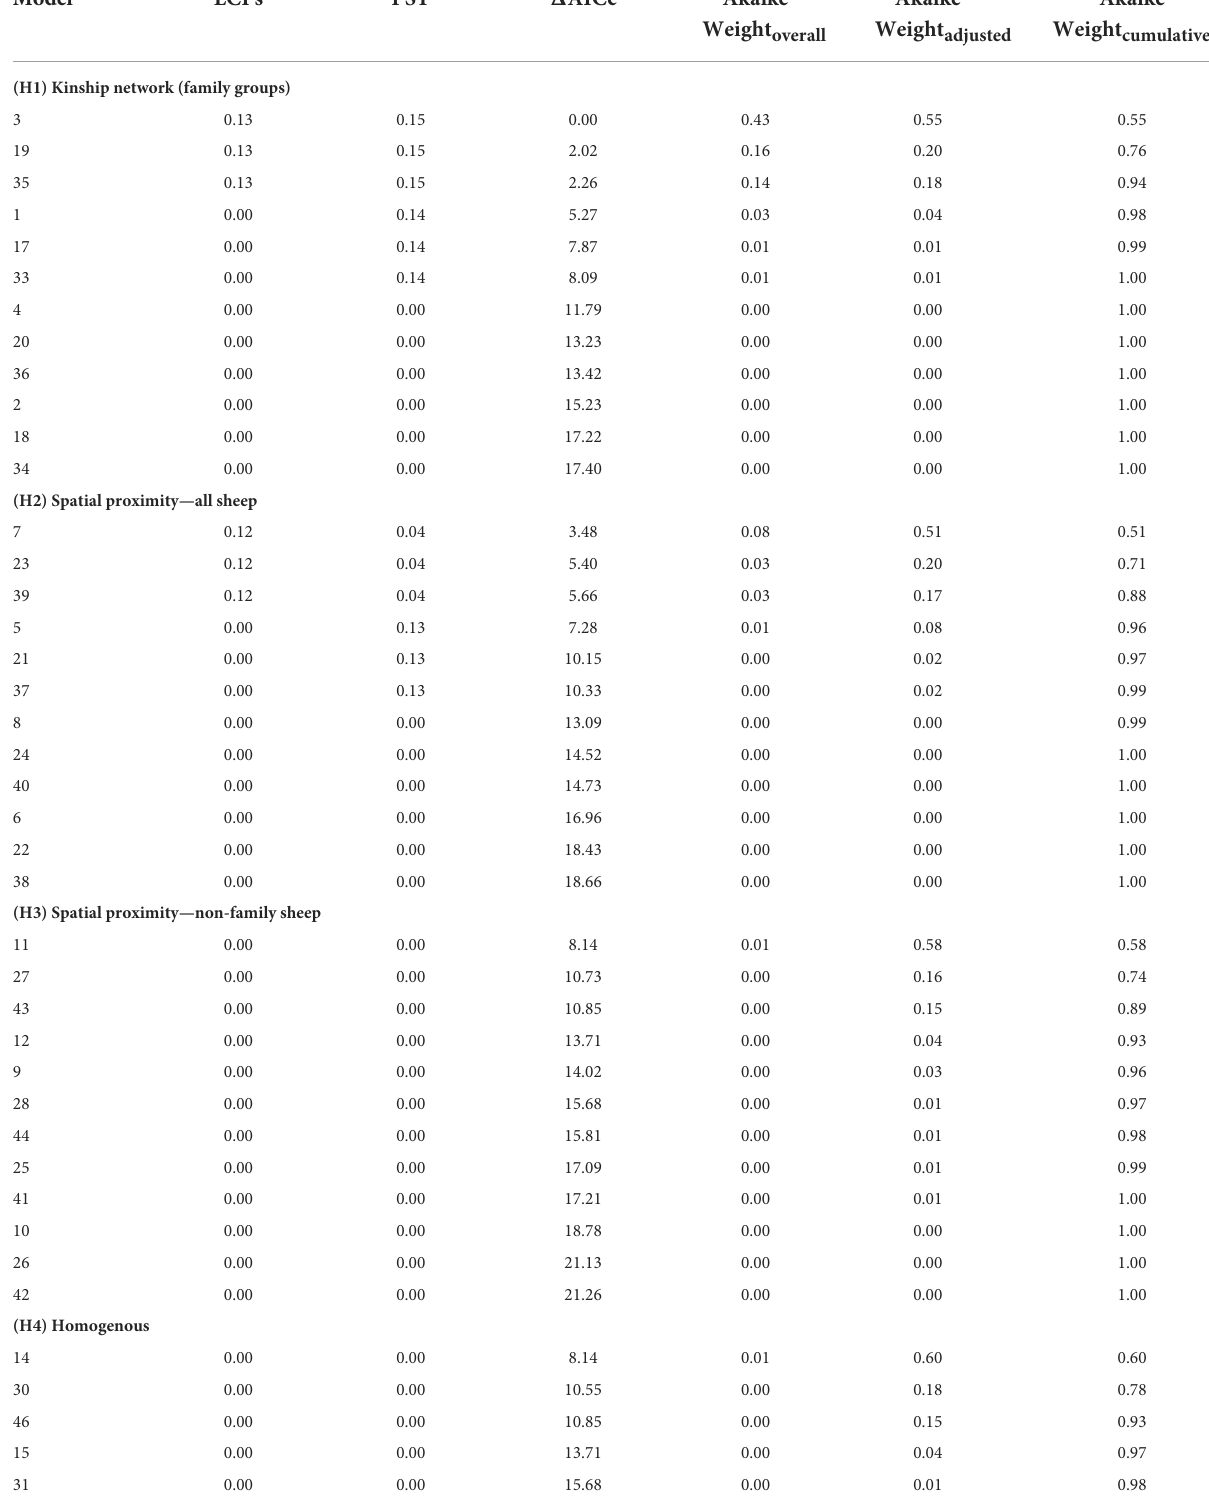
TABLE 4 Lower confidence interval for the s parameter, the corresponding proportion of cases estimated to be by social transmission, and Akaike Weights for each model, ranked by overall Akaike Weight. Model a LCI s PST 1 AICc Akaike